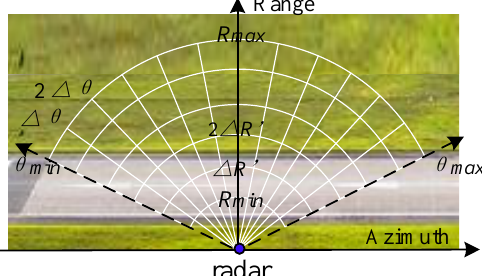
Figure 1. The scene is divided into several resolution cells, and the background level is saved as clutter-map (CM) matrix and updating with the radar sensor scanning.